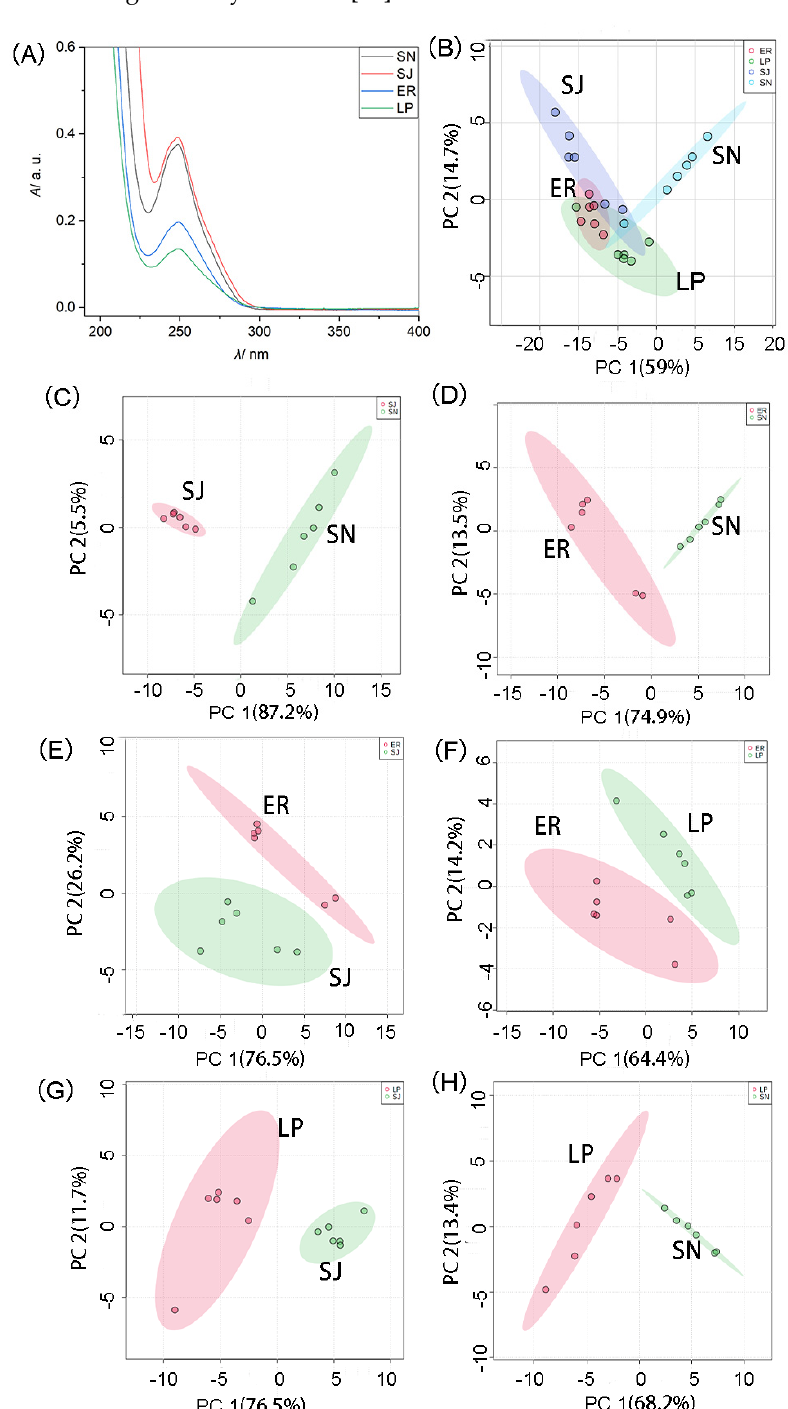
them are significantly different [28].